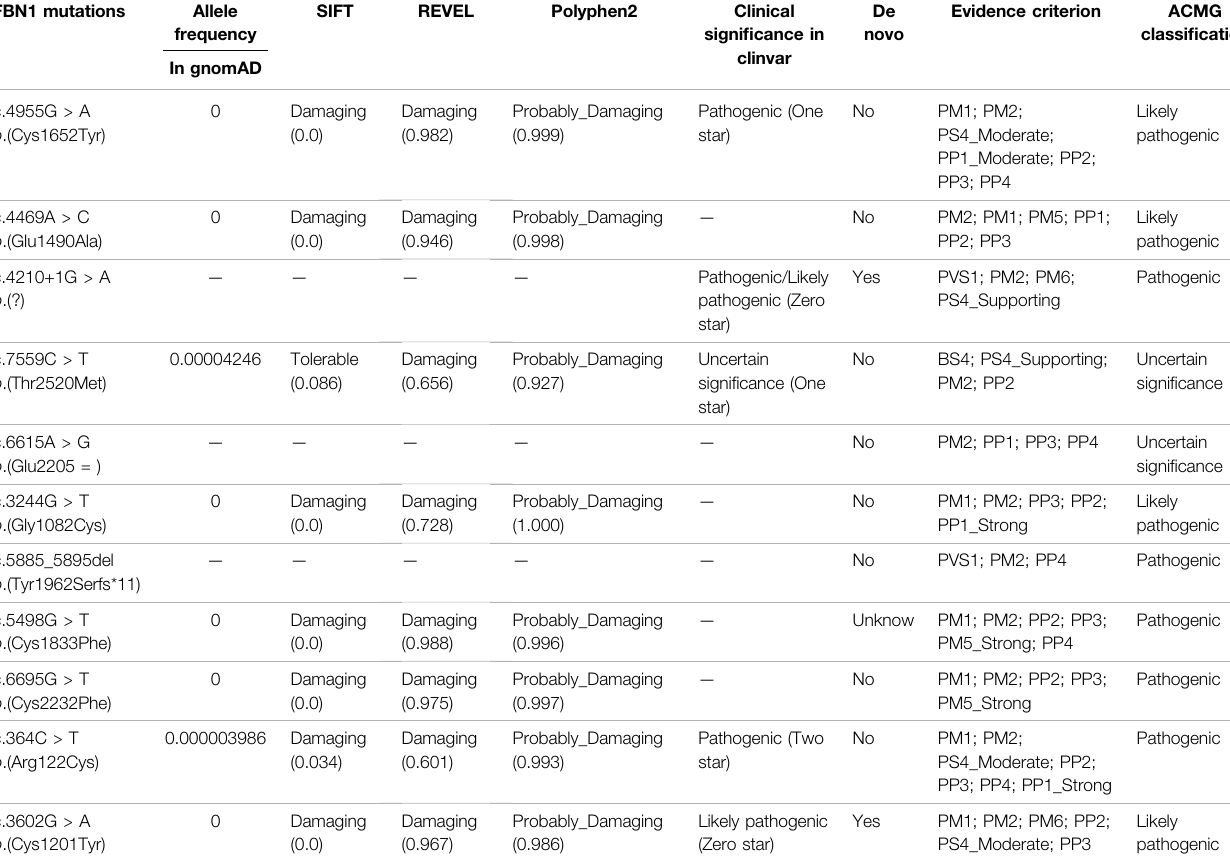
TABLE 3 | Classi fi cation of pathogenicity of FBN1 mutations identi fi ed from 11 Marfan